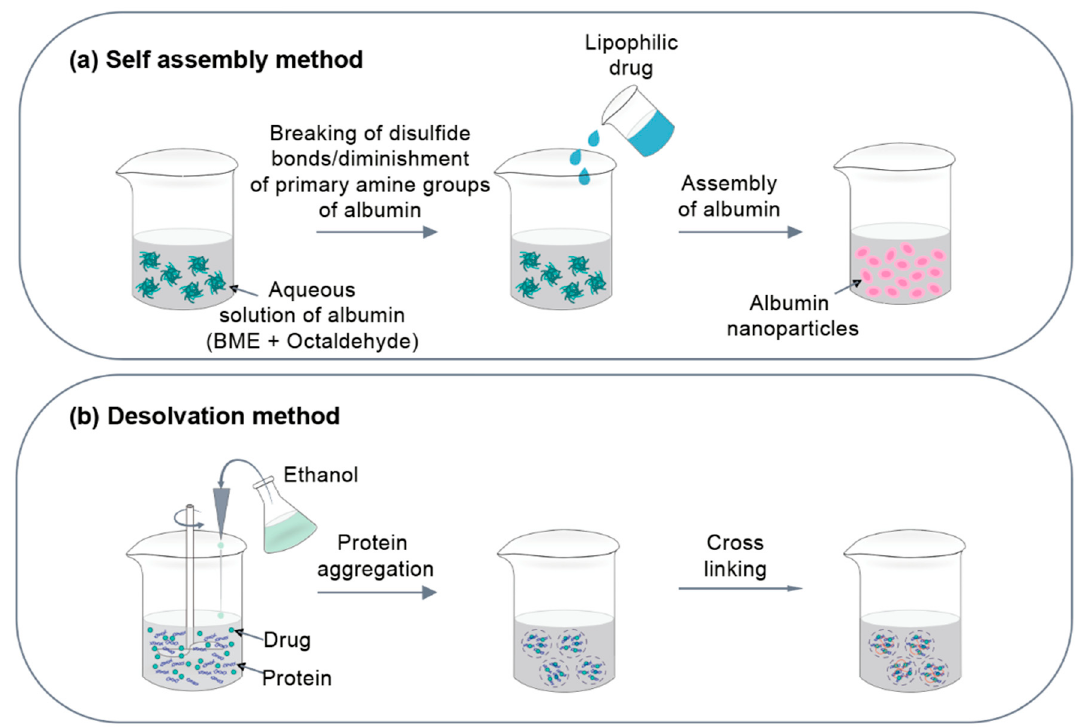
Figure 5. ( a ) In the self-assembly method, individual protein chains are dissolved in an aqueous solution and a CMT exceeding the CMC to spontaneously generate protein micelles during the formation of nanosized aggregates. ( b ) In the desolvation method, nanoparticles are prepared through a simple process of adding a desolvating agent to a protein solution containing